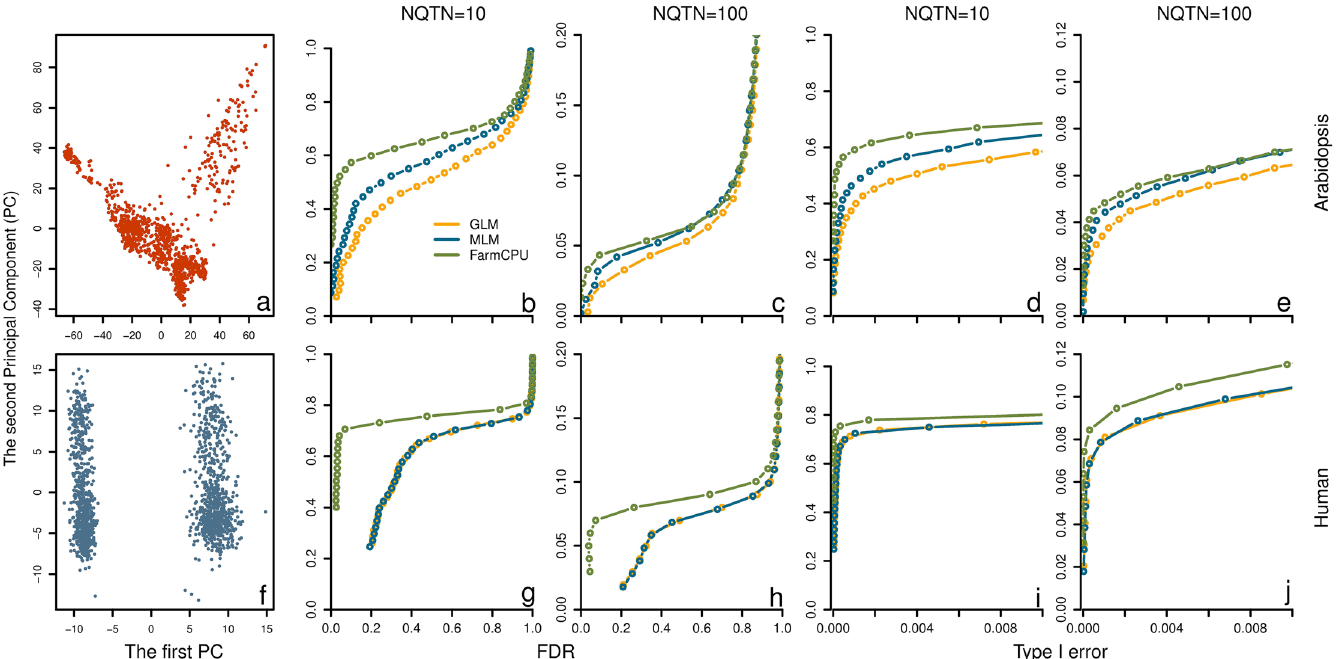
Fig 5. Power in structured populations at different levels. Three methods were employed to examine these populations, including GLM, MLM and FarmCPU. The top panel (a to e) and bottom panel (f to j) display the low and high levels of population structure, represented by Arabidopsis and human populations, respectively. The dataset from Arabidopsis population consists of 1,178 individuals genotyped with 250,000 SNPs. The dataset from human population consists of 1,500 individuals genotyped with 500,000 SNPs. The population structures are displayed by the scatter plot on the first two principal components derived from 10% of SNPs sampled randomly from Arabidopsis thaliana (a) and human (f) , respectively. Additive genetic effects were simulated with 10 and 100 QTNs. The QTNs were randomly sampled from all the SNPs in each dataset. Residuals with normal distribution were added to the genetic effect to form phenotypes with heritability of 0.5. Power was examined under different levels of FDR and Type I error. A positive SNP is considered a true positive if a QTN is within a distance of 50,000 base pairs on either side, otherwise is considered a false positive. Power under different levels of FDR is displayed in subfigures b, c, g, and h . Power under different levels of Type I error is displayed in subfigures d, e, i , and j